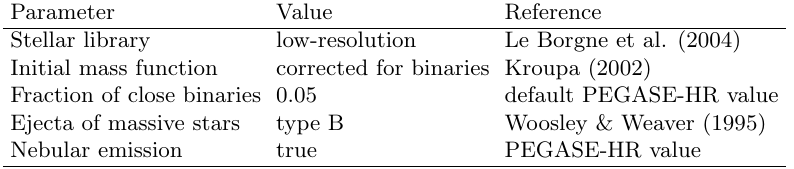
Table 1. PEGASE-HR parameters Parameter Value Reference Stellar library low-resolution Le Borgne et al. (2004) Initial mass function corrected for binaries Kroupa (2002) Fraction of close binaries 0.05 default PEGASE-HR value Ejecta of massive stars type B Woosley & Weaver (1995) Nebular emission true PEGASE-HR